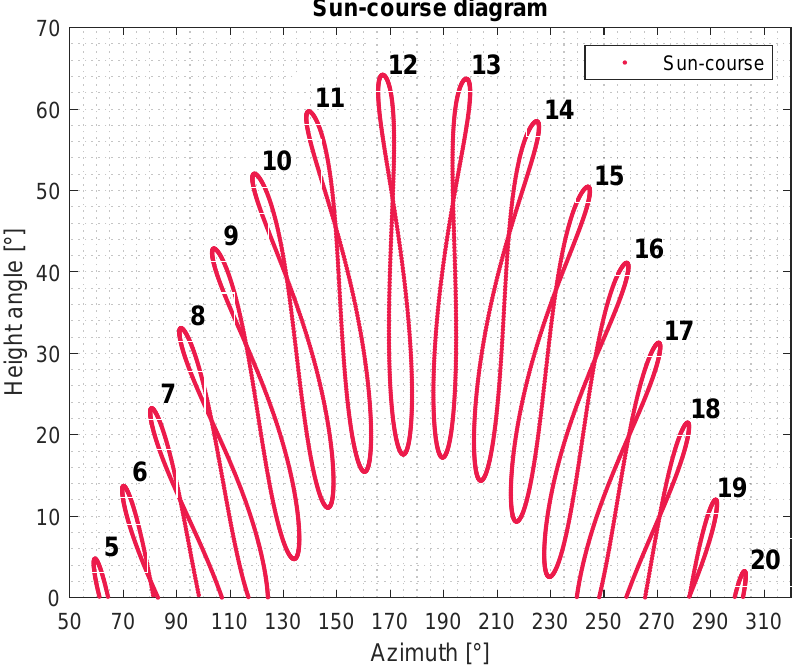
Figure 2. Solar paths for Stuttgart (Germany): φ = 48.8°, L local = 9.2° and L zone = 15°. The curves in the form of a number eight “8”, or lemniscata, are the solar analemmas representing the position of the sun in the sky when it is observed every day at the same time and from the same observation point along a